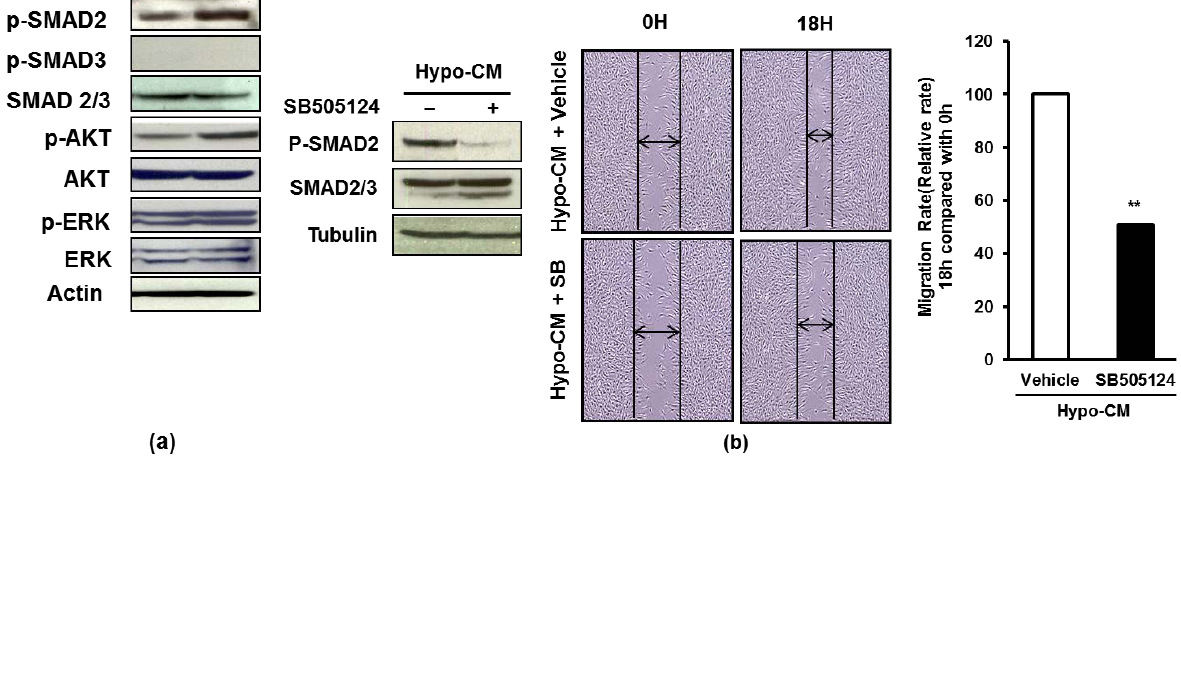
Figure 4. AF-MSC-hypoCM influences the migration of human dermal fibroblasts through regulating TGF-β/SMAD2 and PI3K/AKT signal pathways. ( a ) Western blot assay was performed to determine the protein levels of phosphorylated SMAD2/3, AKT and ERK in human dermal fibroblasts that were cultured in either AF-MSC-norCM or AF-MSC-hypoCM for 18 h, showing that the expression of phosphorylated SMAD2 and AKT were increased in response to AF-MSC-hypoCM; ( b ) Human dermal fibroblasts were cultured for 18 h in the presence or absence of TGF-β inhibitor, SB505124. The protein levels of phosphorylated SMAD2 were decreased in response to AF-MSC-hypoCM. A significant increase in the migration of human dermal fibroblasts into the wound area was observed in response to AF-MSC-hypoCM treatment at 18 h after scratch injury. Arrows indicate the distance of wound, showing the decrease in AF-MSC-hypoCM treatment; ( c ) Human dermal fibroblasts were cultured for 18 h in the presence or absence of PI3K inhibitor, LY294002. The protein levels of phosphorylated AKT were decreased in response to AF-MSC-hypoCM. A significant increase in the migration of human dermal fibroblasts into the wound area was observed in response to AF-MSC-hypoCM treatment at 18 h after scratch injury. Arrows indicate the distance of wound, showing the decrease in AF-MSC-hypoCM treatment; and ( d ) Human dermal fibroblasts were cultured for 18 h in the presence or absence of both SB505124 and LY294002. The protein levels of phosphorylated SMAD2 and AKT were decreased in response to AF-MSC-hypoCM. A significant increase in the migration of human dermal fibroblasts into the wound area was observed in response to AF-MSC-hypoCM treatment at 18 h after scratch injury. Arrows indicate the distance of wound, showing the decrease in AF-MSC-hypoCM treatment. Data are expressed as the mean ± SD. ** p <